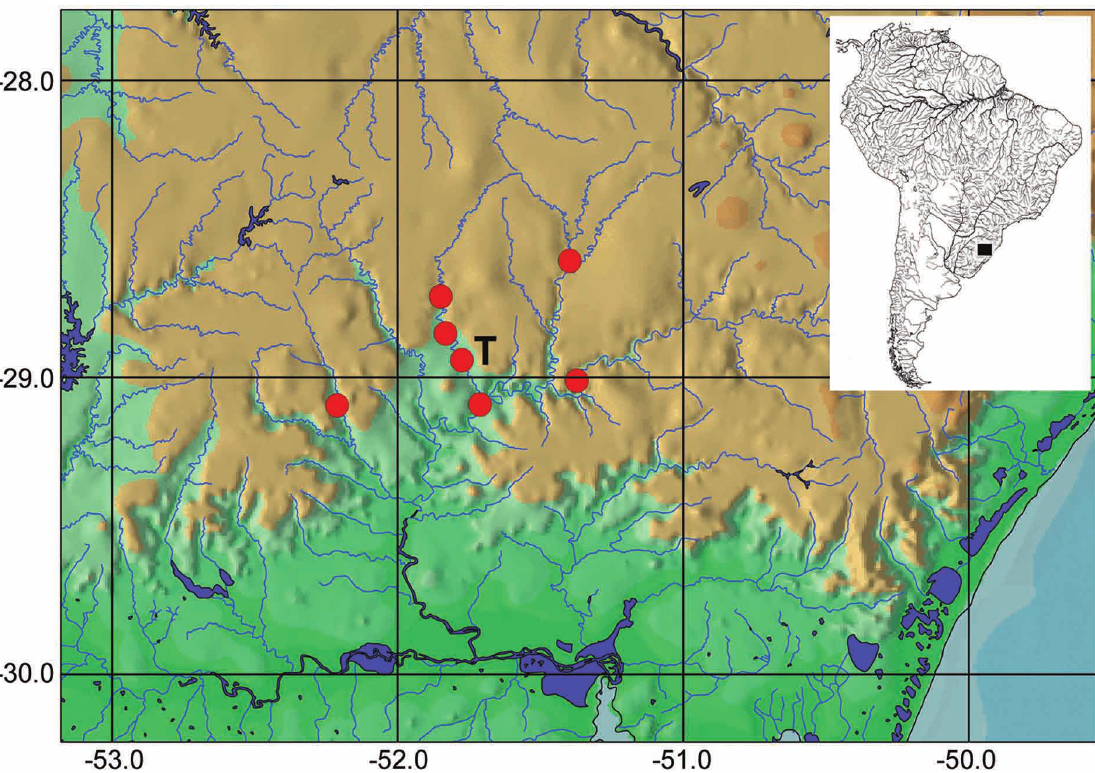
Fig. 3. Map of southern Brazil showing the distribution of the examined material of Astyanax bagual . Some symbols represent more than one lot or locality. T = type